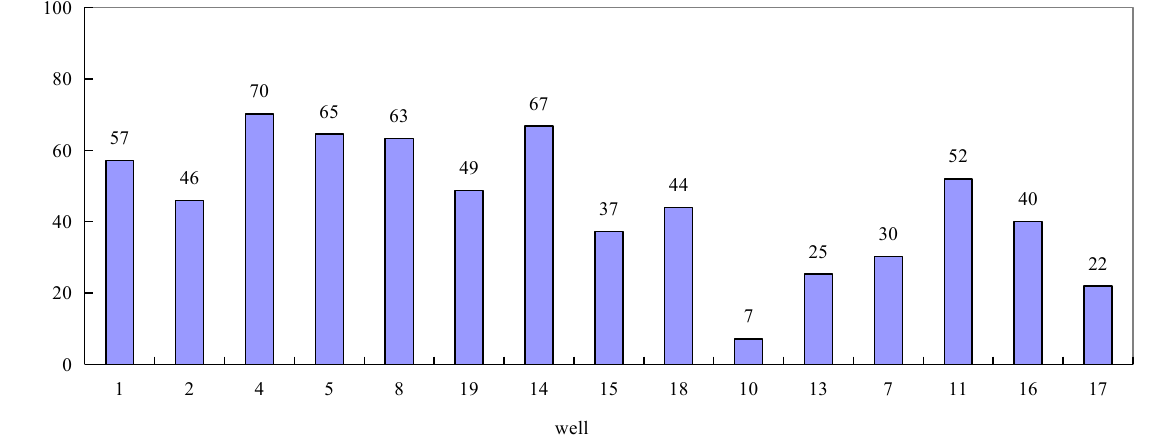
Figure 12. Net gross ratio chart of buried-hill reservoir section in PL oilfield. Net gross ratio data were obtained from logging data.